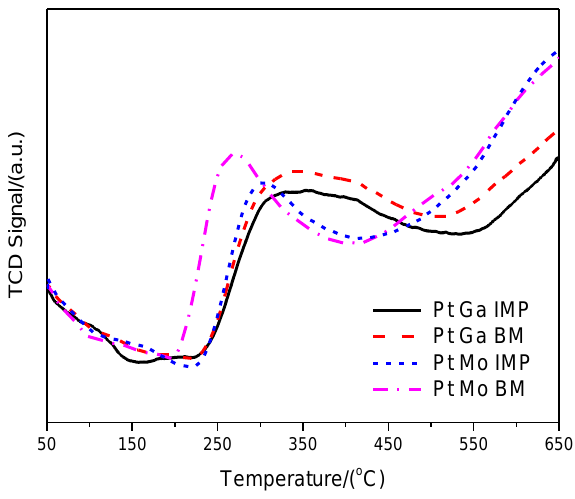
Figure 4. H 2 -TPD profiles of Pt Mo BM, Pt Mo IMP, Pt Ga BM, and Pt Ga IMP samples.